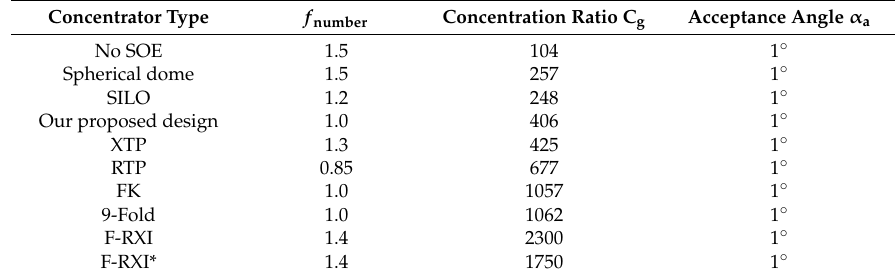
Table 2. Comparison of concentration ratio and f number with the same acceptance angle between our proposed design and other designs that described in Minano et al.